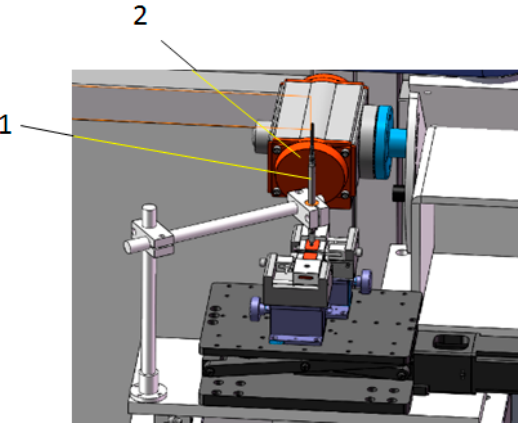
Figure 11. Schematic diagram of the height measurement of the sample under test. 1—displacement sensors; 2—data-acquisition equipment.